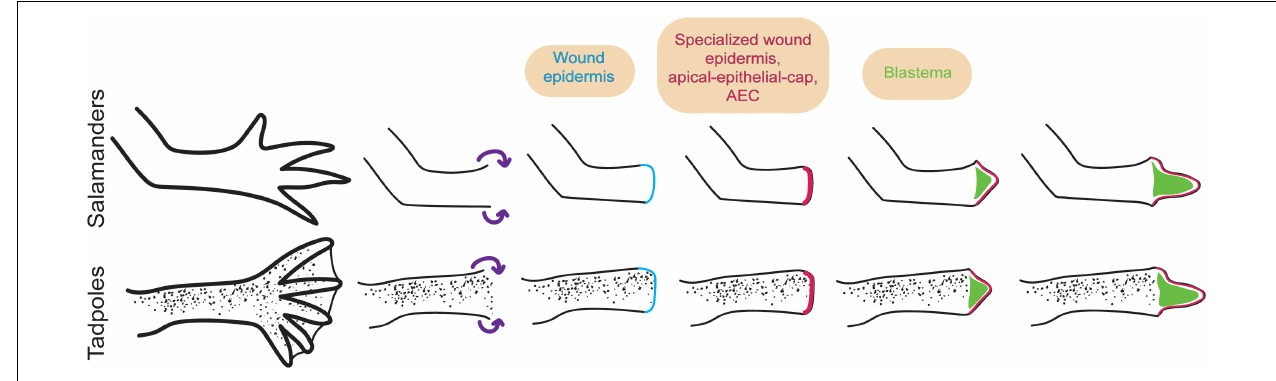
FIGURE 1 | The wound epidermis (WE) and the specialized wound epidermis form in a step-wise manner during amphibian limb regeneration. Limb regeneration is initiated with amputation in (top) salamanders and (bottom) tadpoles. The remaining stump epidermal cells migrate to the amputation plane (purple arrows) and form the WE (light blue). Then the WE becomes the specialized wound epidermis [apical-epithelial-cap (AEC)] (dark pink) associated with regeneration (Christensen and Tassava, 2000). Afterward, the AEC leads to blastema formation and subsequent outgrowth (Tassava and Loyd, 1977). Although the presence of the AEC in early and mid-stages of regeneration is demonstrated by tissue morphology and staining assessments (e.g., Han et al., 2001), its presence in late stages is observed only with tissue morphology assessment.